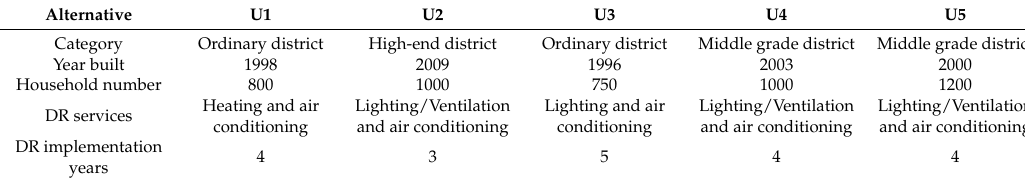
Table 5. Expert group characteristics description.